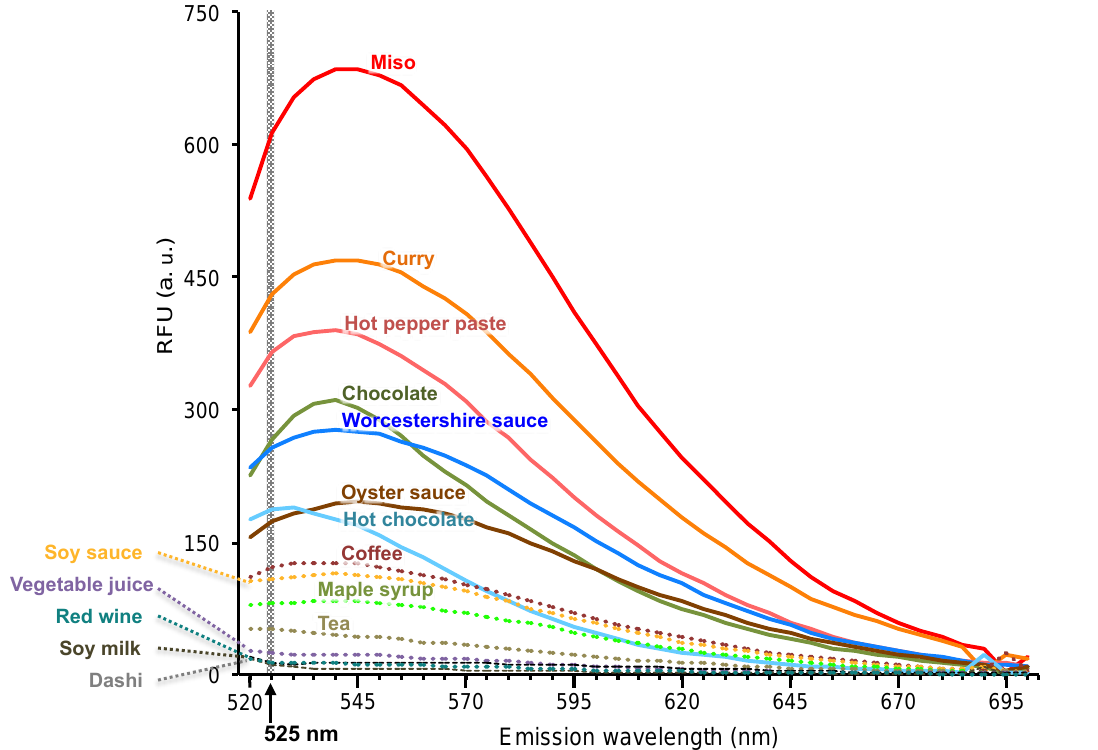
Figure 1. Fluorescence spectra of various foods. Fluorescence spectra upon irradiation with fluorescent light (490 nm). The gray range shows the emission wavelength (525 nm) used for the representative Ca 2+ -sensitive fluorescent probe Fluo-8.